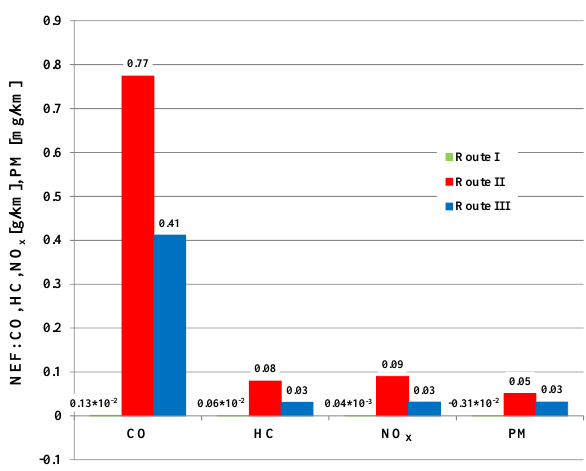
Fig. 6. Net road emission of CO, HC, NO x and PM from road tests on individual routes